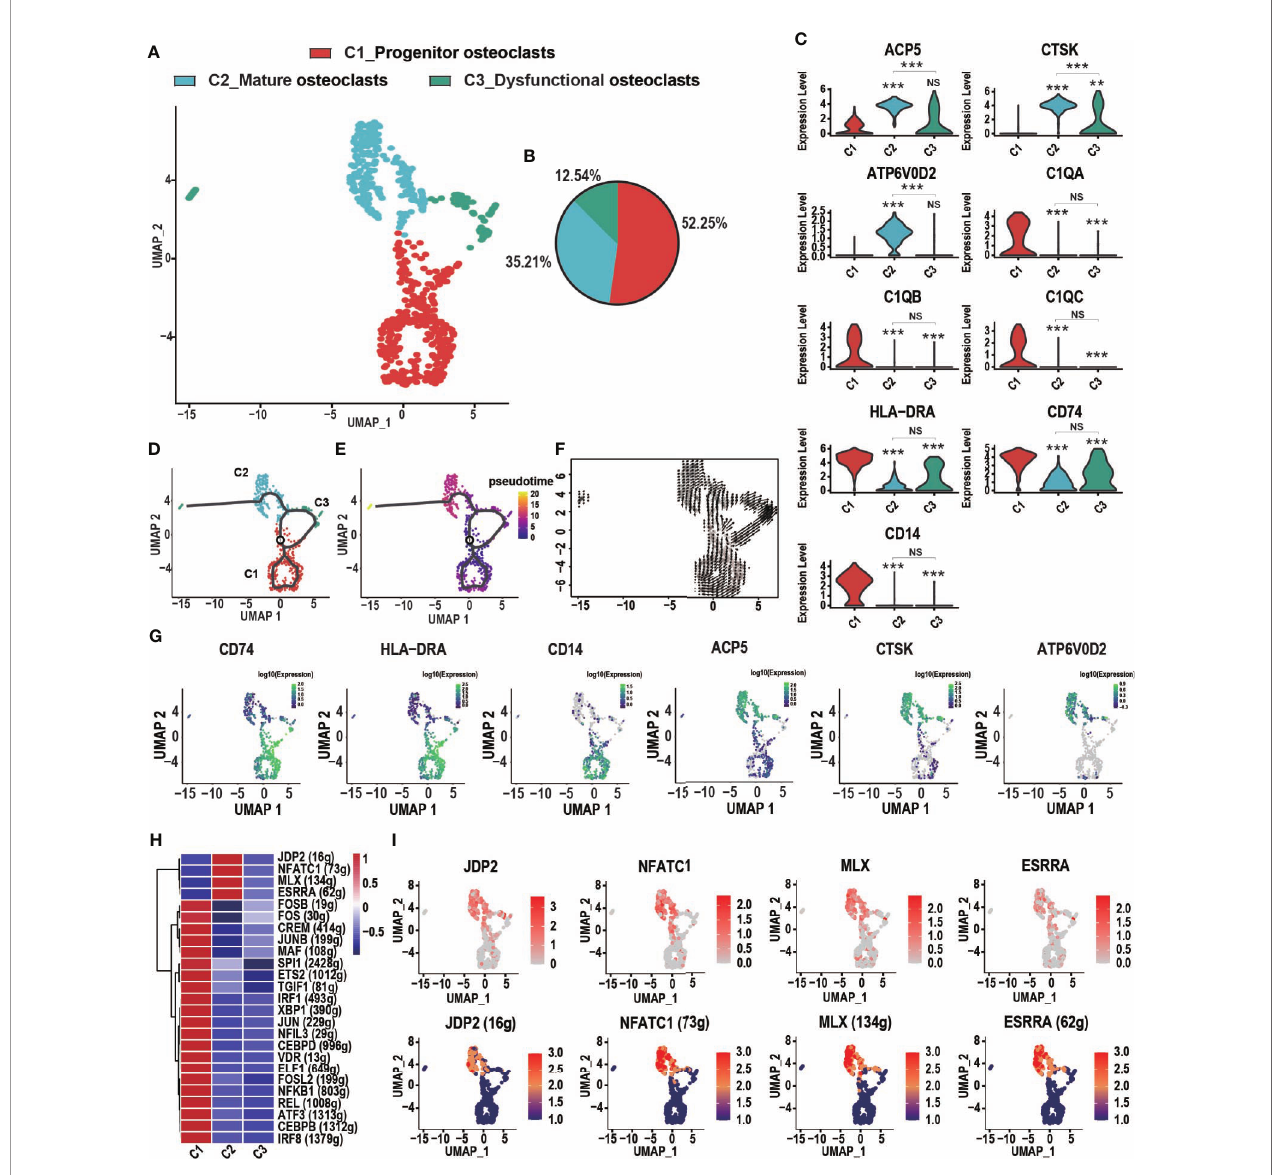
FIGURE 3 | Heterogeneity of osteoclasts in GCTB lesions. (A) An UMAP plot shows three main subtypes of osteoclasts: C1_Progenitor osteoclasts, C2_Mature osteoclasts, and C3_Dysfunctional osteoclasts. (B) A pie chart depicts the cell composition of the osteoclasts. (C) Violin plots showing relevant marker genes in the osteoclast subtypes (**P < 0.01, ***P <0.001, NS: No statistical signi fi cance). (D, E) The dynamics of the osteoclast subclusters showed with a monocle 3 trajectory plot. (F) Velocity fi eld projected onto the UMAP plot of the osteoclasts. Arrows indicate the direction of the differentiation and its average velocity. (G) The expression levels of marker genes (CD74, HLA-DRA, CD14, ACP5, CTSK, and ATP6V0D2) related to the differentiation of osteoclasts. (H) Heatmap of the AUC scores of transcription factor expression regulation by SCENIC. (I) UMAP plot of osteoclasts color-coded for expression level (up) and the AUC of the estimated regulon activity of these transcription factors (down). GCTB, giant cell tumor of bone; UMAP, uniform manifold approximation and projection for dimension reduction; SCENIC, single-cell regulatory network inference and clustering; AUC, area under the